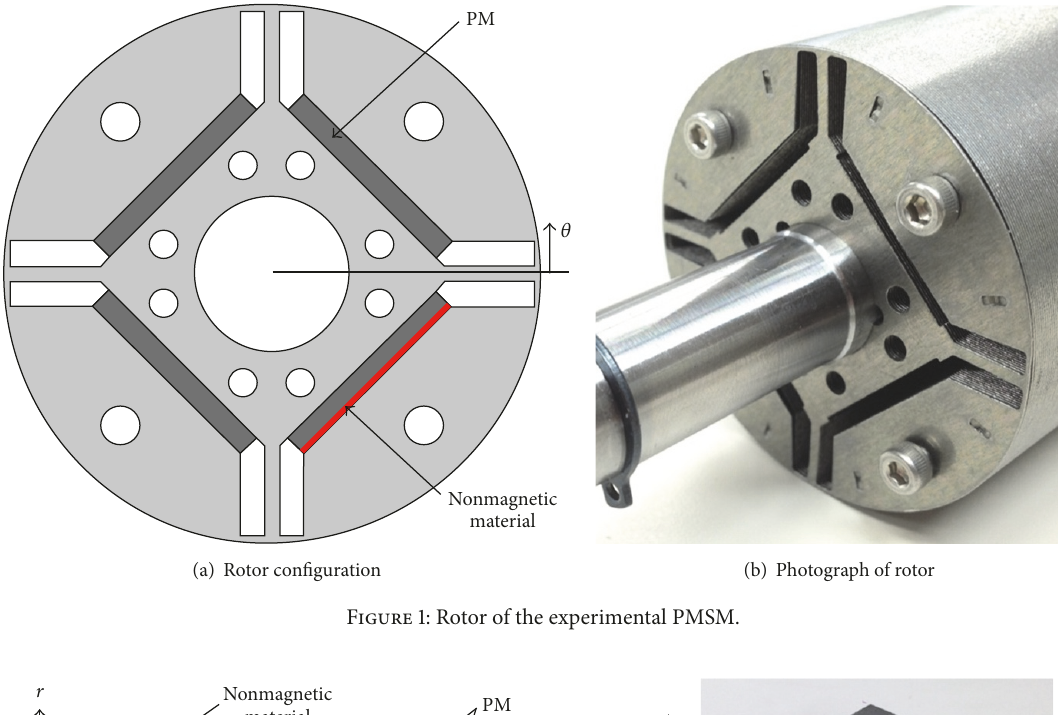
Figure 1: Rotor of the experimental PMSM.